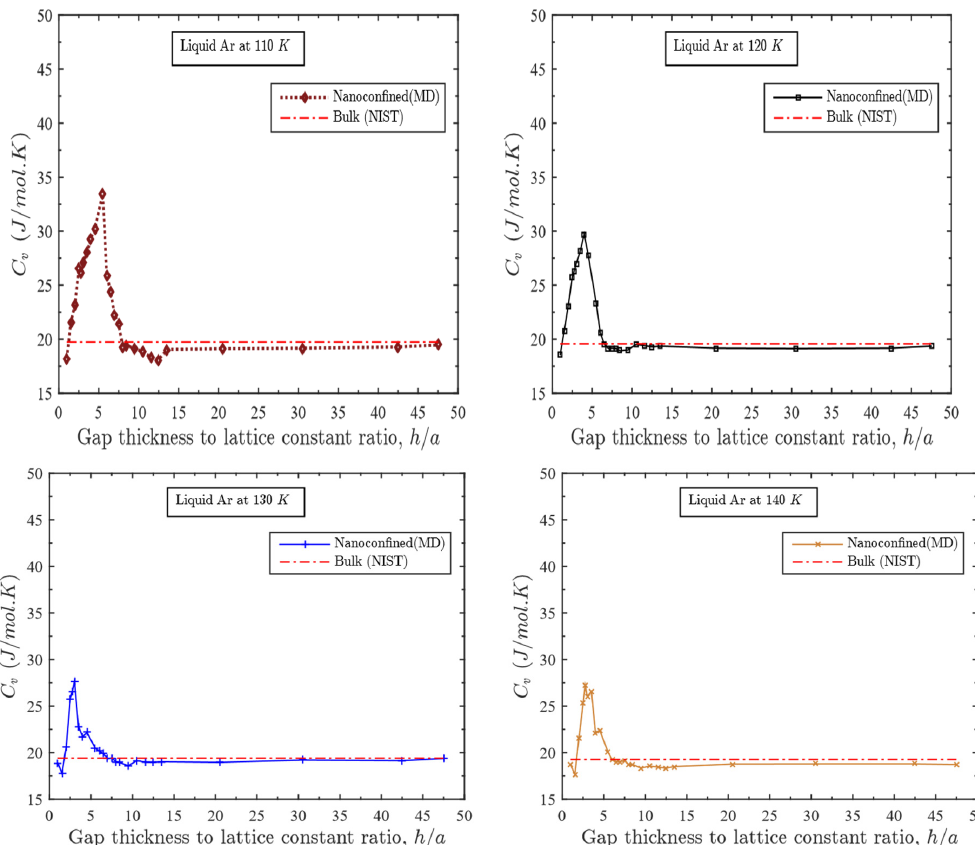
Figure 6. Heat capacity of nanoconfined liquid as a function of gap thickness at various temperatures (110 K to 140 K).